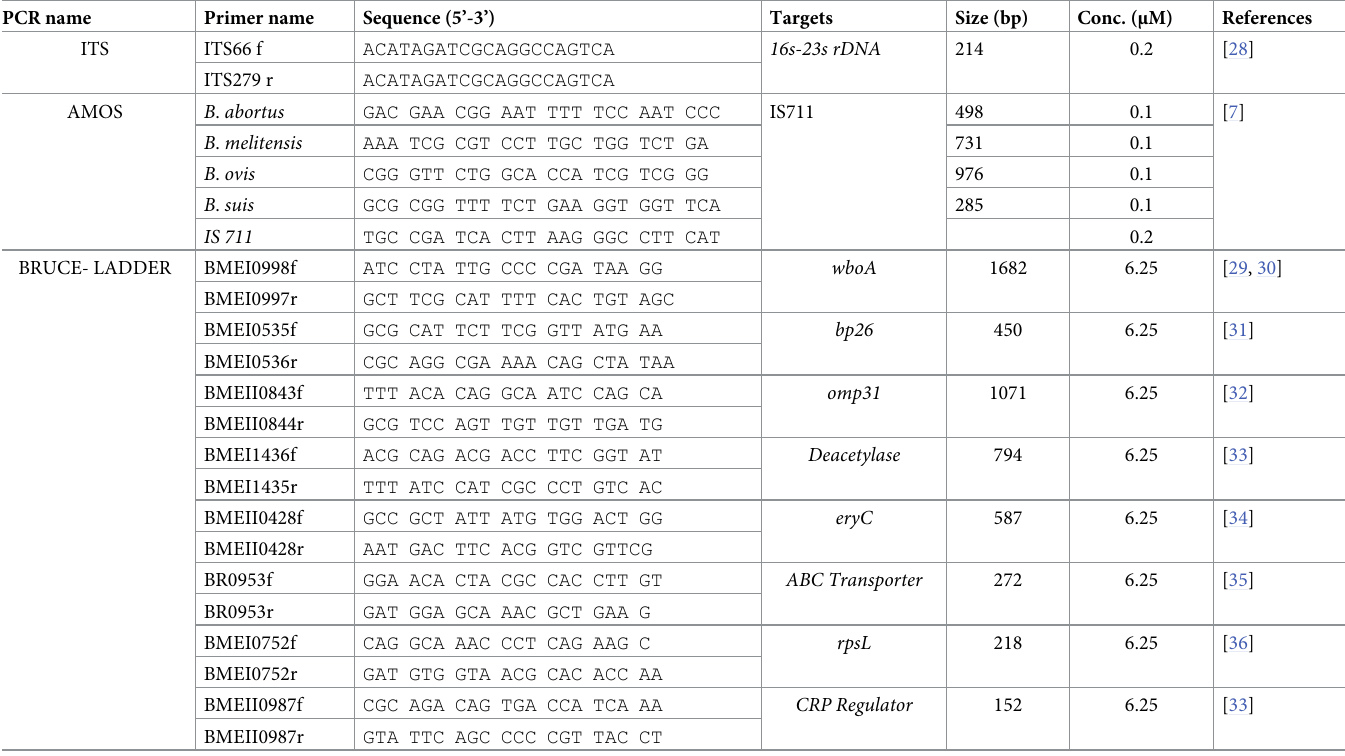
Table 1. Sequences of oligonucleotide primers used for the distinction of Brucella species isolated from slaughtered cattle in